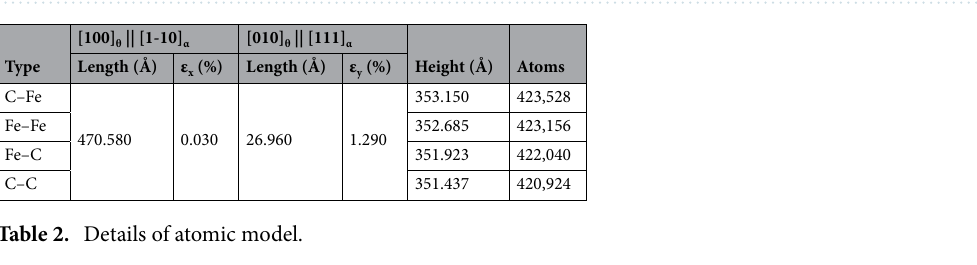
Figure 5. Projection of local structure at ferrite/cementite interface.